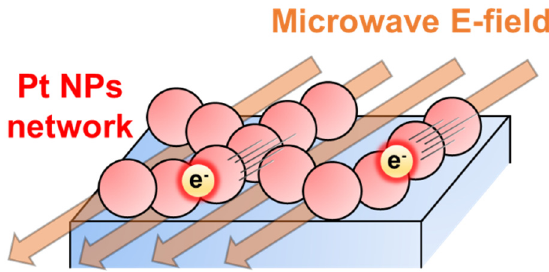
Figure 11. Proposed mechanism of the drastic MW heating in Pt NPs network.